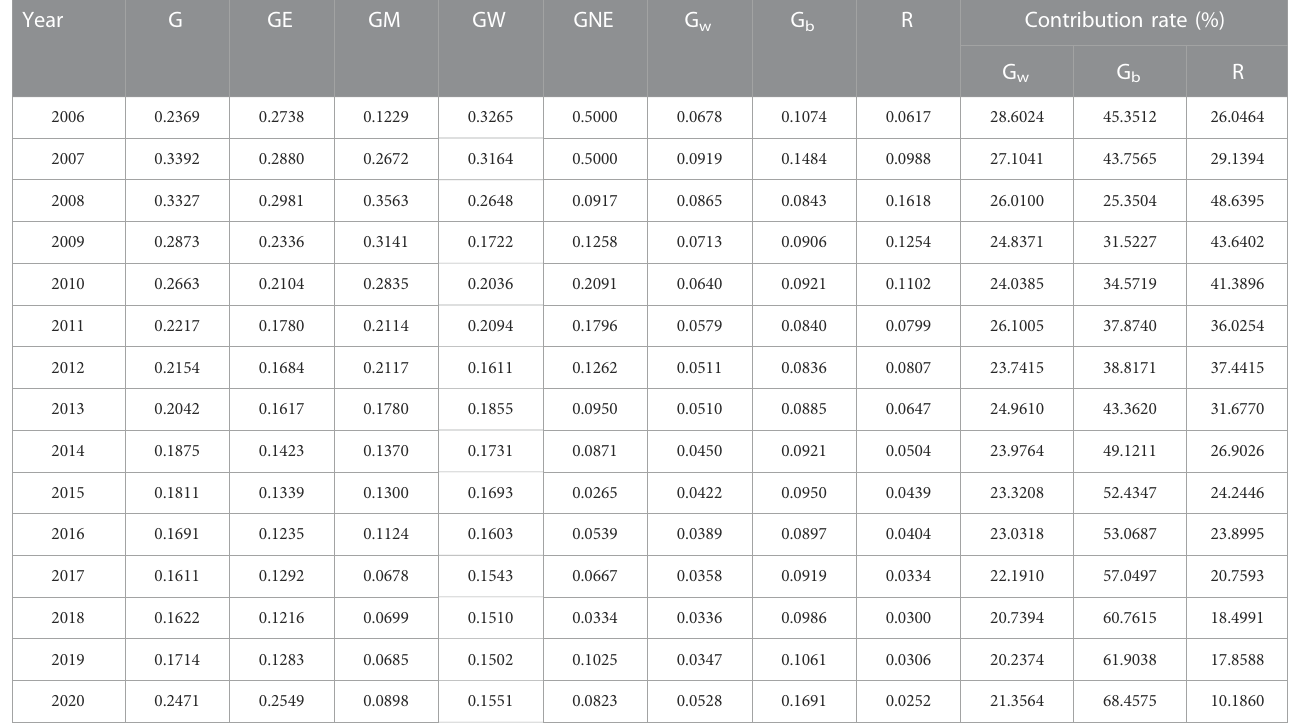
TABLE 2 Decomposition of the spatial gap in China ’ s county solid waste harmless disposal capacity and contribution